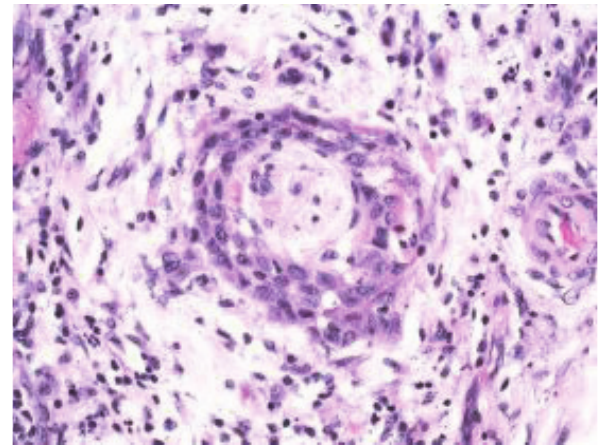
Fig. 1. Perineural spreading of oral squamous cell carcinoma (Hematoxylin and Eosin staining,